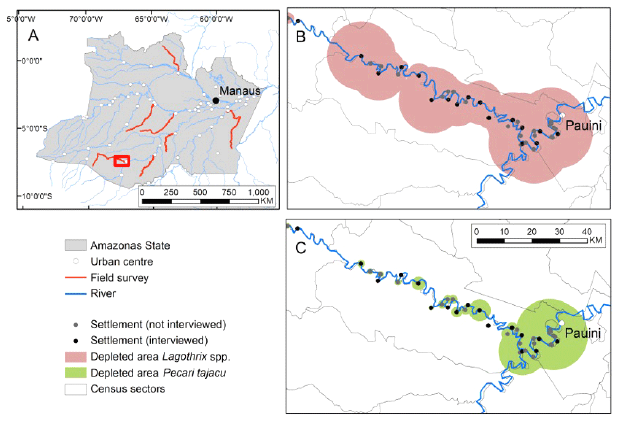
Fig. 1 . (A) Map of rivers surveyed within Amazonas State, Brazil, with inset red box of Pauiní. Numbers 1-7 refer to the following rivers (in order): Rio Aracá, Rio Abacaxí, Rio Tefé, Rio Coarí, Rio Jacaré, Rio Pauiní, and Rio Ituxí. (B) Depletion of woolly monkeys ( Lagothrix spp.) around visited settlements (reported depletion distances) and unvisited settlements (estimated depletion distances) along a section of the lower Rio Pauiní. (C) Same as above, for collared peccary ( Pecari tajacu ).